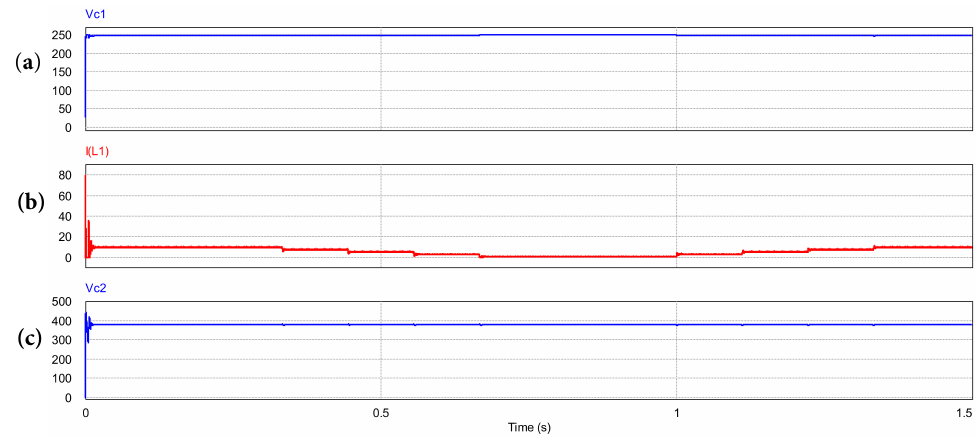
Figure 14. Boost converter 2.5 kW at 380 V with state feedback controller. ( a ) input voltage, ( b ) in- ductor current and ( c ) output voltage.